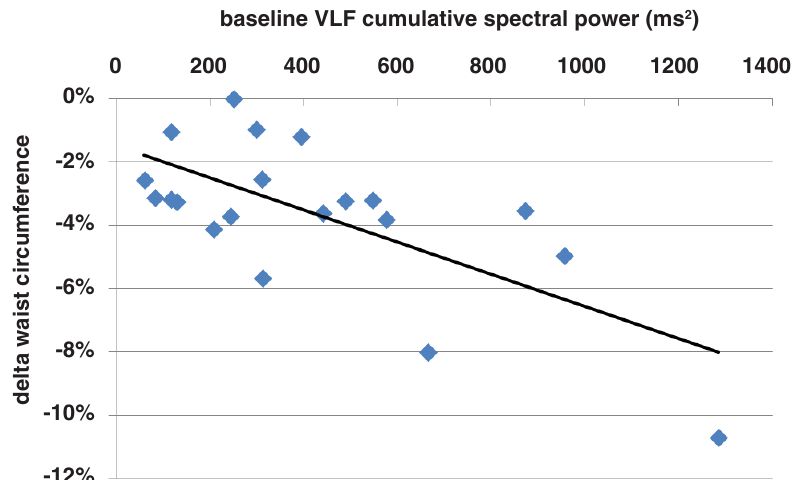
Figure 3. Treatment efficacy as assessed by delta waist circumference 1 month after the last treatment significantly correlates with initial VLF (very-low frequency) cumulative spectral power (r=-0.58, p<0.001).